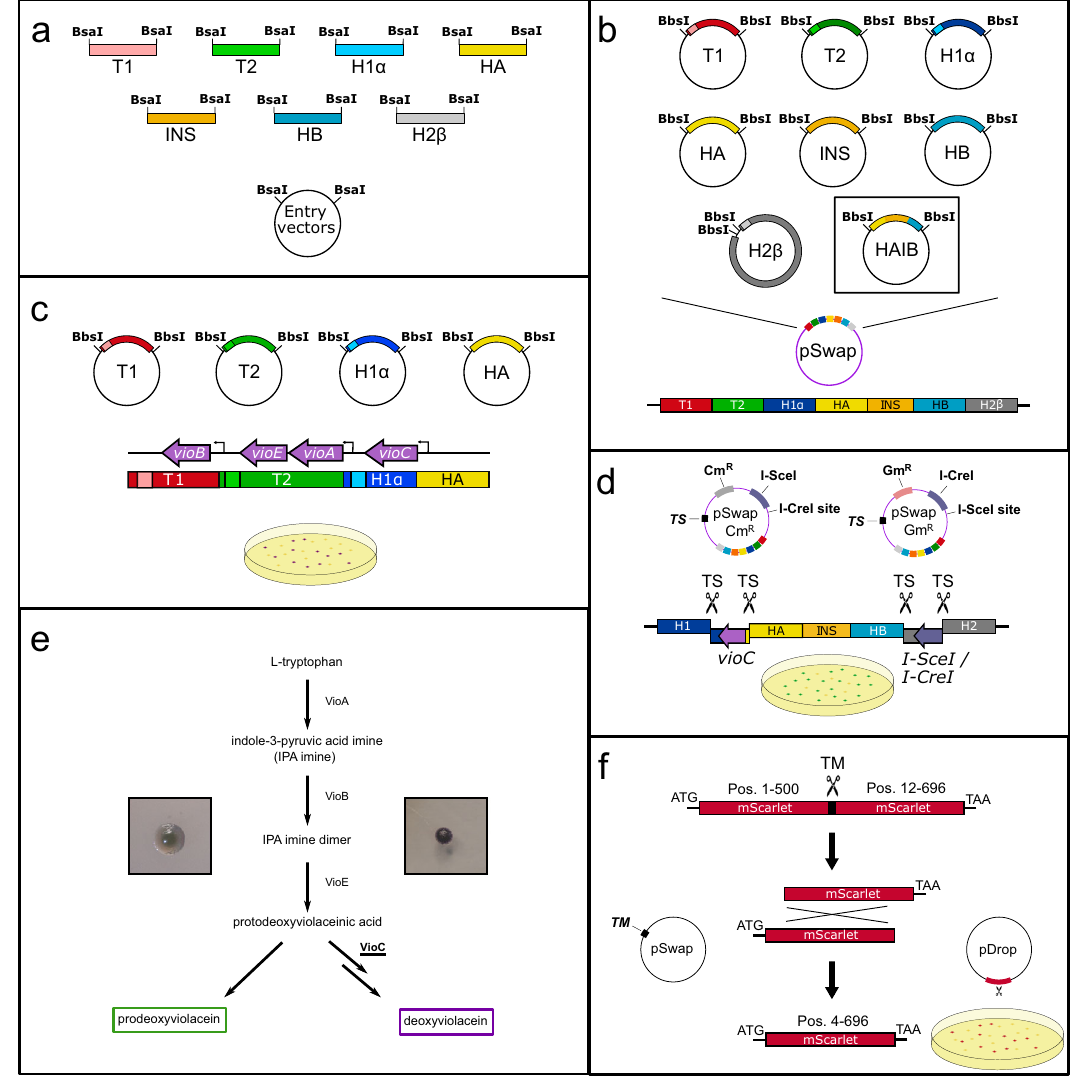
Fig. 2 pSwap assembly and recombination overview. CRISPR SWAPnDROP uses a modular assembly system for the pSwap construction. It consists of seven modules ( fi ve for scarless integration) harbouring sgRNA expression cassettes for target sites (T1,T2), homologous regions (H α , H β , H1, H2, HA, HB) and insert DNA (INS). a Each of those parts can be cloned into a different entry vector using the type-IIS restriction enzyme BsaI. b Each of those seven ( fi ve for scarless integration) modules are used to assemble the pSwap plasmid. The assembly takes place in a one-pot, one-step reaction using the type- IIS restriction enzyme BbsI. Therefore, it is possible to combine and recycle different modules for the desired approach. c The correct assembly of the pSwap plasmid is ensured by the expression of the biosynthetic pathway of deoxyviolacein. Each of the fragments (T1, T2, H1 α , HA) harbour parts of